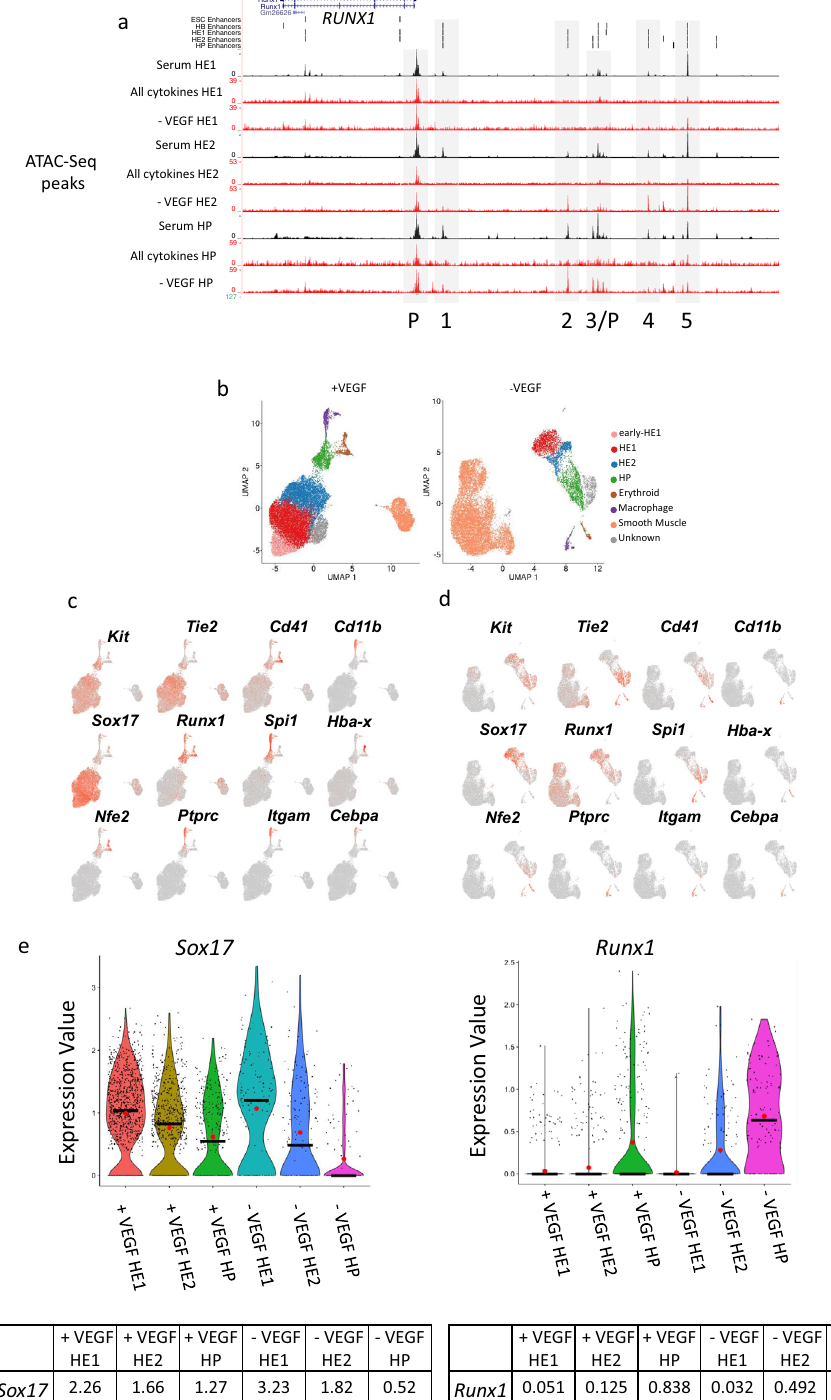
presence (+VEGF) and absence of VEGF (-VEGF). UMAP clustering analysis was performed after all data were pooled. c , d Gene expression levels of the indicated genes with ( c ) and without VEGF ( d ) areprojectedonthe clusters. e Violin plots of expression values from 6 clusters for n =2266 cells (black line representing the median, red dot the mean and black dots the spread of the data) and mean nor- malized (Seurat log normalized) gene expression levels of Sox17 and Runx1 in the indicatedcelltypesinthepresenceandabsenceofVEGFcalculatedfromsinglecell expression